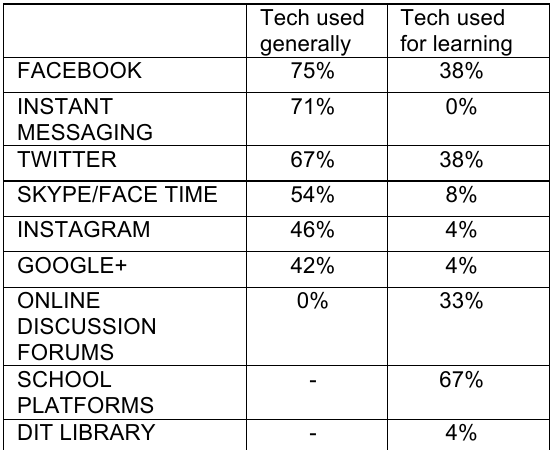
Table 1: Technology used by students for personal communication and to support